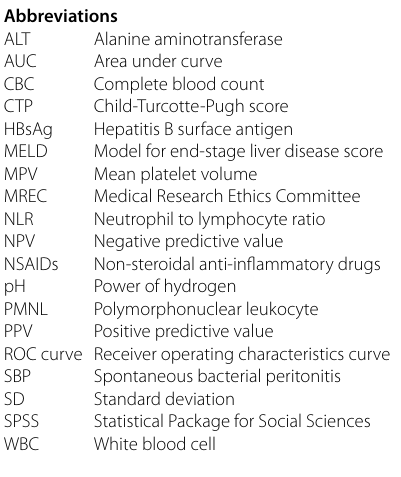
MPV for diagnosis of +